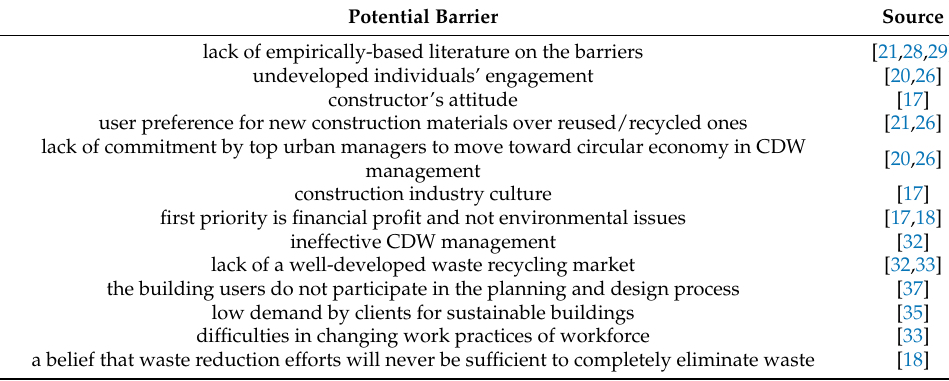
Table 3. Summary of social barriers to increasing CDW recycling and re-using.